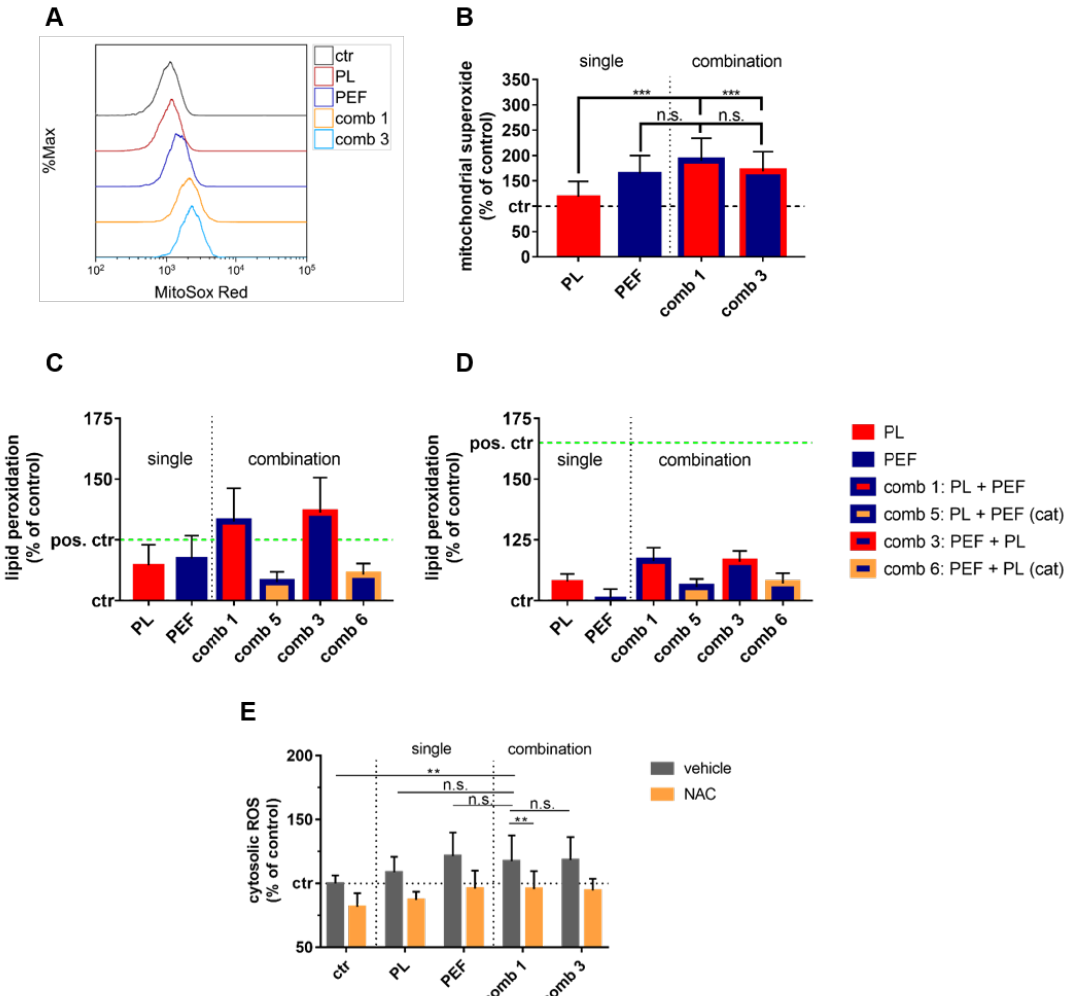
Figure 6. Cellular ROS and lipid peroxidation were observed with mono and combination treatments. The plasma exposure time was 40 s, and the electric field strength was 0.9 kV/cm. Mitochondrial superoxide was determined using MitoSox Red and flow cytometry ( A ) and quantified ( B ). A t-test was performed to determine significant differences. Lipid peroxidation was measured using boron-dipyrromethene (BODIPY) staining flow cytometry directly after treatment ( C ) and 1 h later ( D ). Cumene hydroperoxide (200 μM) was used as a positive control. Intracellular ROS content was quantified using flow cytometry ( E ). The results of the t-test are shown in Table 4. Data are shown as one representative ( A ) or mean + S.E. ( B – E ) of three independent experiments. ctr = control; PL = plasma; PEF = pulsed electric fields; comb = combination; n.s. = not significant; cat = catalase.